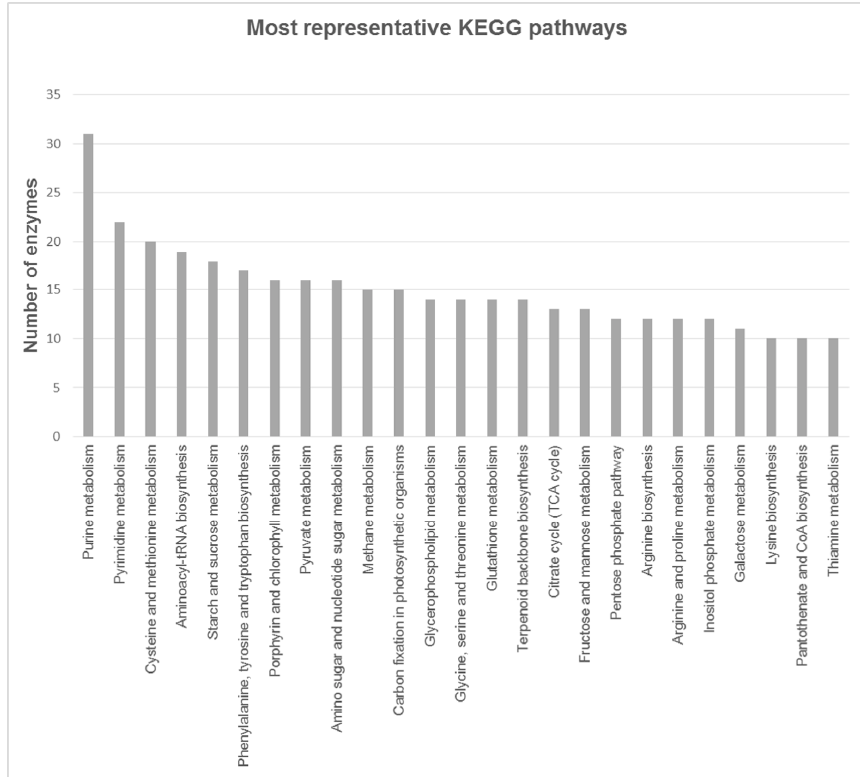
Figure 3. The most representative KEGG pathways associated with all predicted genes. Only pathways with at least eight associated enzymes are represented.